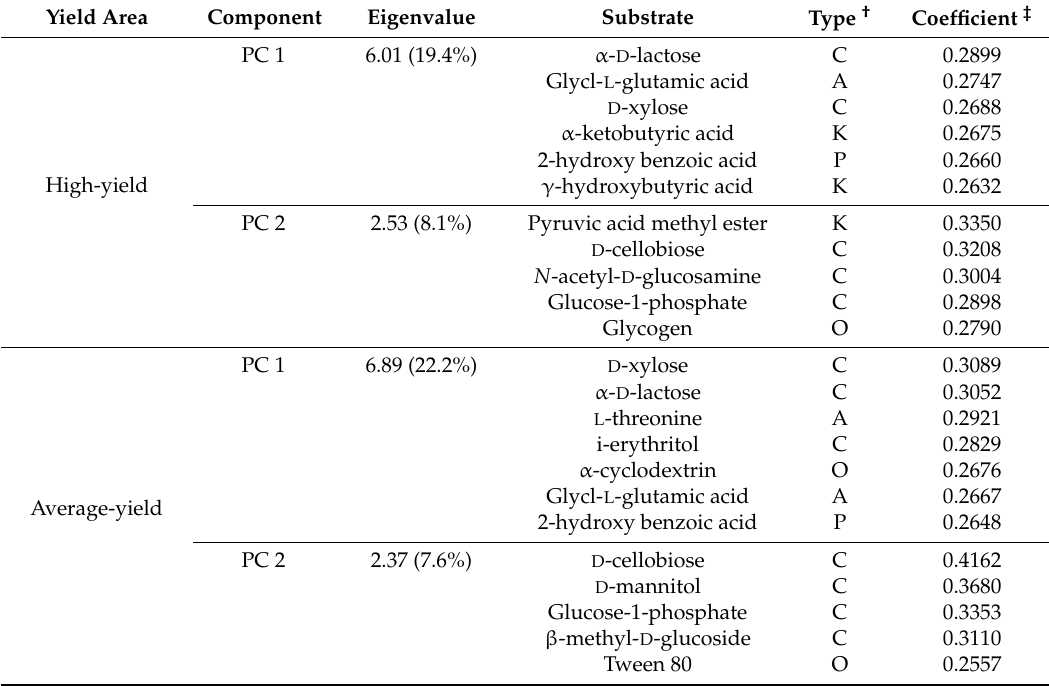
Table 5. Principal components (PCs) 1 and 2, their respective eigenvalues (including percentage of variation explained), substrates loaded in each PC, substrate type, and respective eigenvector for substrate in each PC derived from measurements on EcoPlates TM [4] from high-yield and average-yield areas across Arkansas in 2014 and